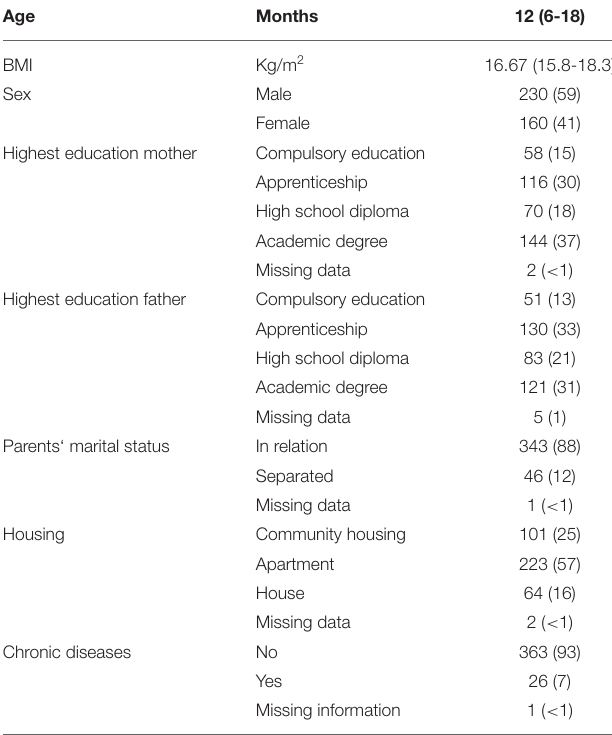
TABLE 1 | Characterization of study